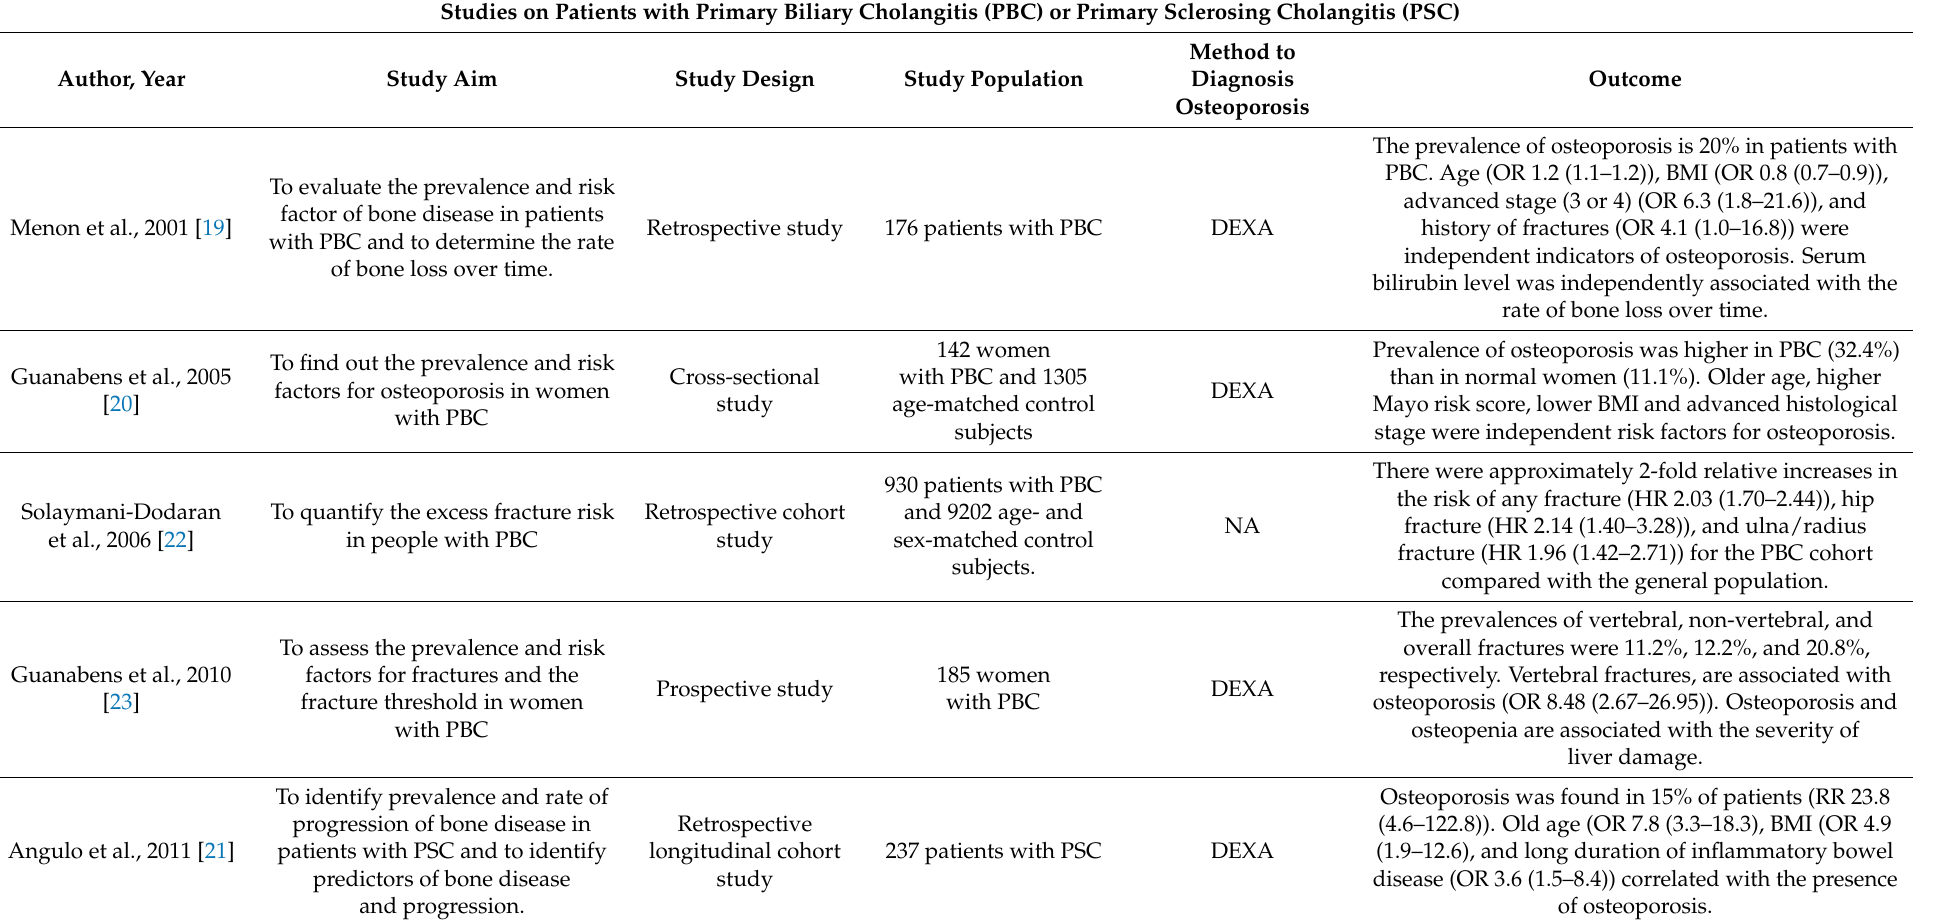
Table 1. Representative clinical studies for osteoporosis in chronic liver